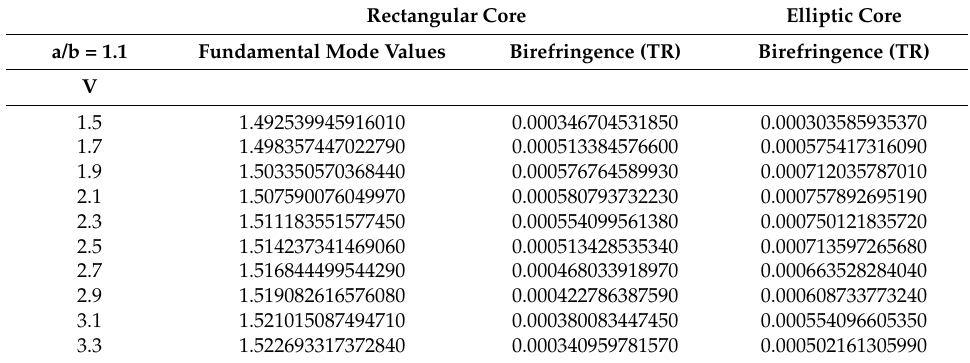
Table 5. Comparison of birefringence for elliptical and orthogonal core